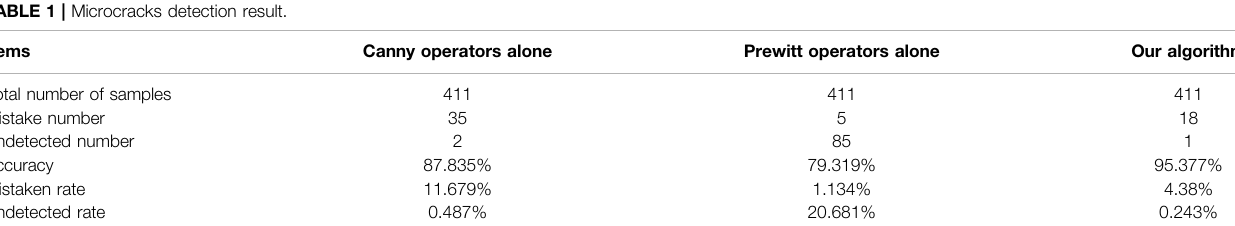
TABLE 1 | Microcracks detection result. Items Canny operators alone Our